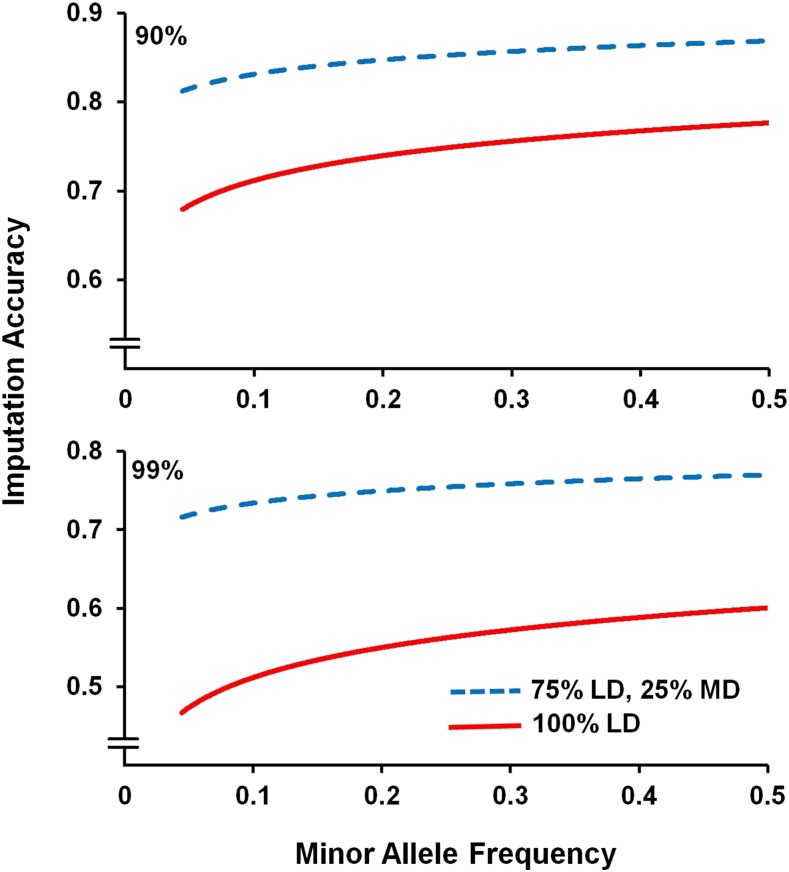
The effect of minor allele frequency on imputation accuracy. The plot shows the imputation accuracy for the MD SNP panel with the two different LD SNP panel densities (90% SNPs masked = 2563 SNPs; 99% SNPs masked = 256 SNPs), plotted against the minor allele frequency of the SNPs using a local regression fit.